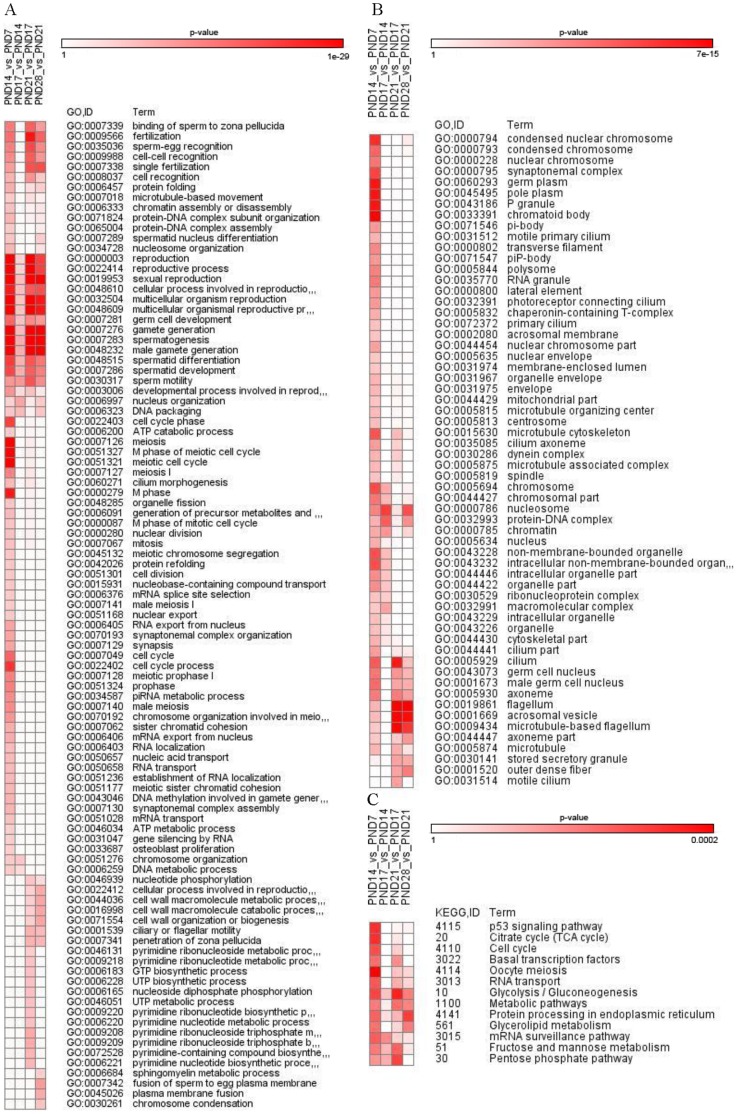
Highest ranked GO terms (p<0.01) with differential expression between sample groups for GO biological processes (A) and cellular components (B) and for KEGG pathways (C).The relative significance of term enrichment is indicated by levels of red shading (the lower the p-value the darker shade of red colour). Heat map was produced with GENE-E (http://www.broadinstitute.org/cancer/software/GENE-E/) using pearson’s correlation metrics and average linkage distance metrics.